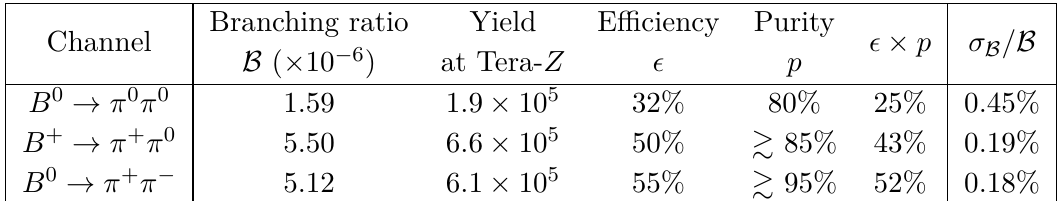
Table 7 . Estimation of B → ππ relative precision (signal yield, efficiency, and purity) at Tera- Z .